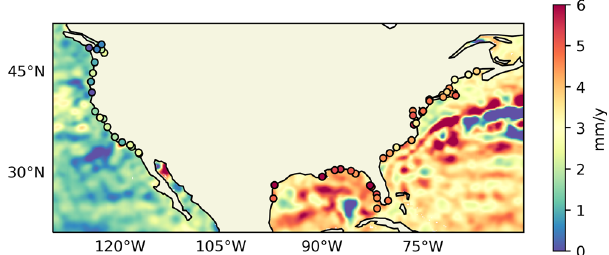
Fig. 1 Satellite-altimetry sea level trends. Observed sea-level trends (1993 – 2018) along the US coast. The map shows geocentric sea-level from satellite altimetry, and the individual dots relative sea-level trends measured by tide